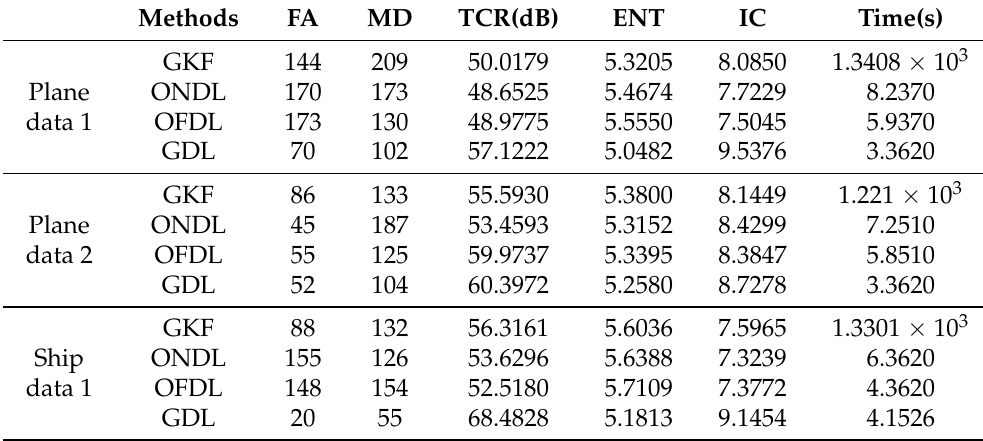
Table 3. Evaluation of real ISAR data image